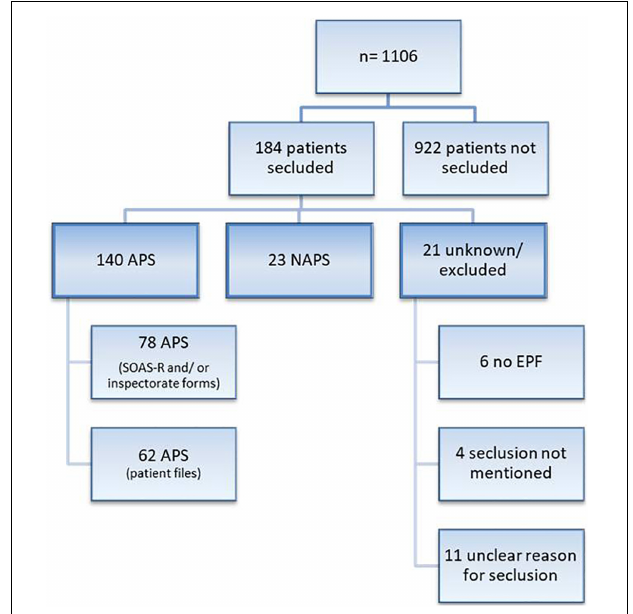
FIGURE 1 | Flowchart of population studied. APS, aggression preceded seclusion; NAPS, no aggression preceded seclusion; SOAS-R, staff observation aggression scale revised; EPF, Electronic Patient